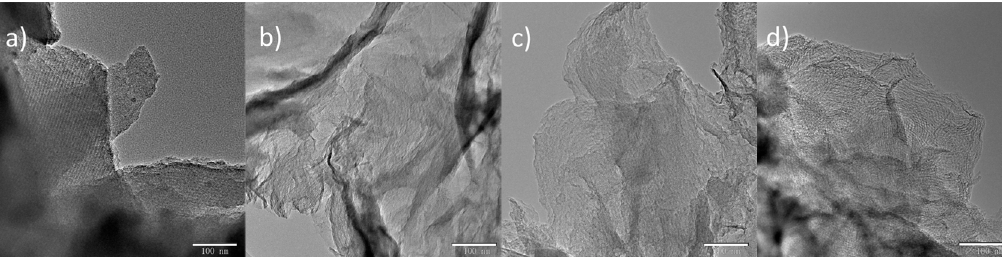
Figure 3. TEM images of the nitrogen-doped mesoporous carbon (NMC)-SiO 2 /GO- x : ( a ) x = 0;